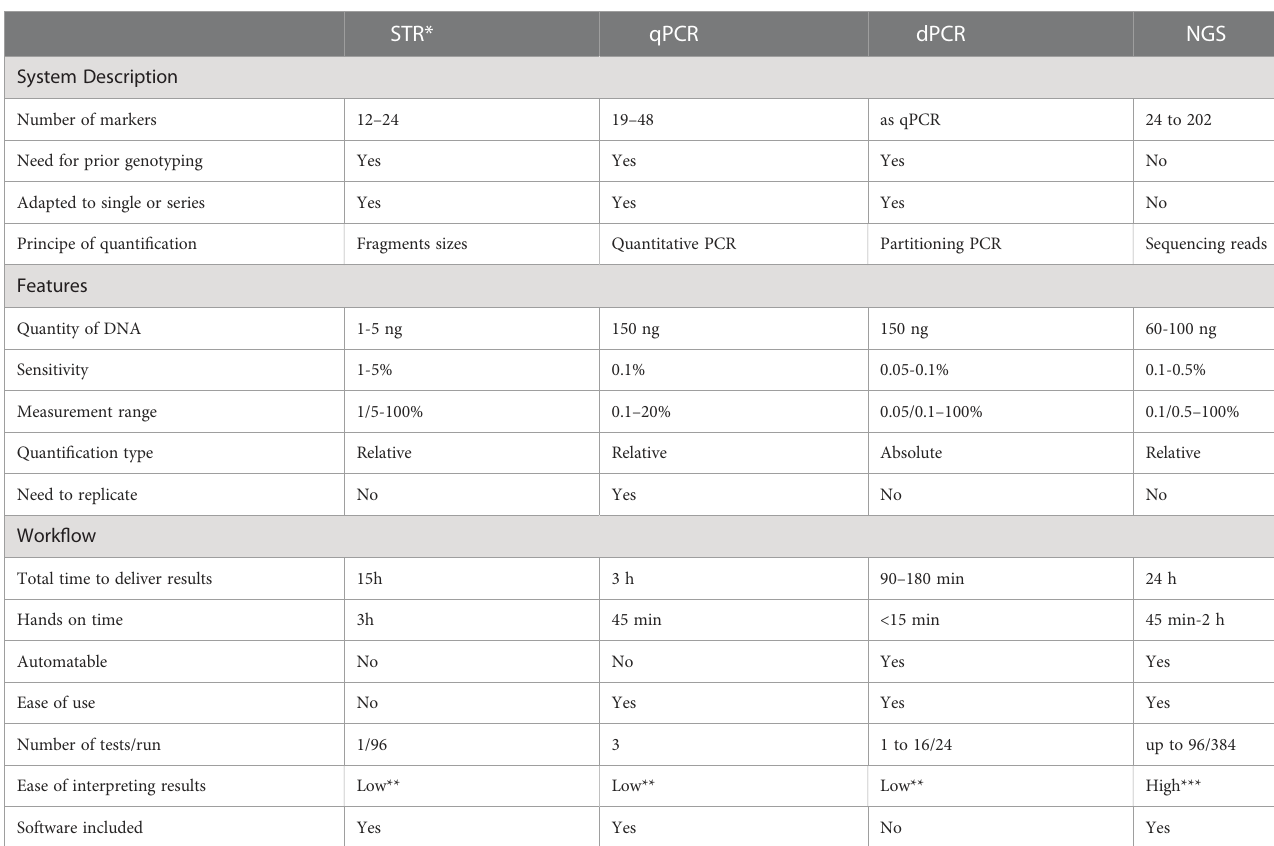
TABLE 1 Comparison of STR, qPCR, dPCR and NGS